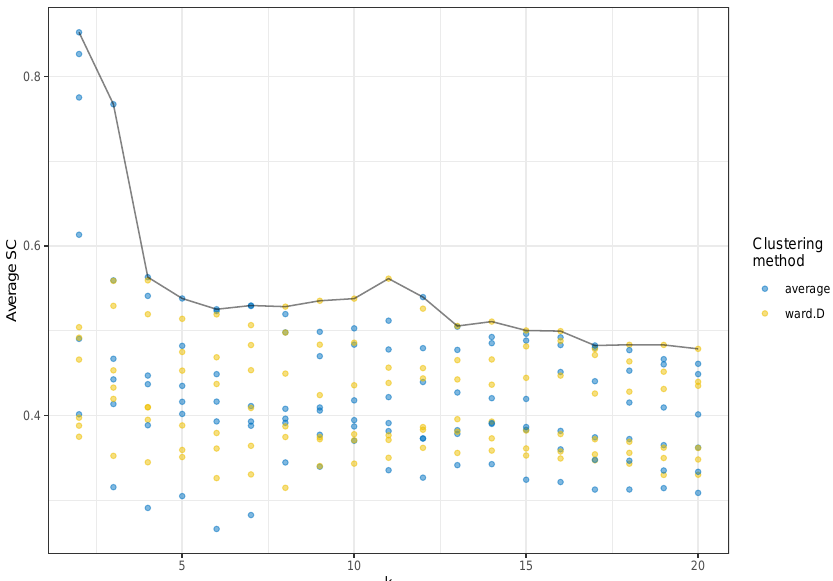
Figure 4. Average silhouette coefficent (SC) by number of clusters (k) and average and Ward clustering methods. For each k-value and clustering method, we can see a point for each generated model, a combination of the minimum embedding distance, and number of neighbors in the UMAP projection.